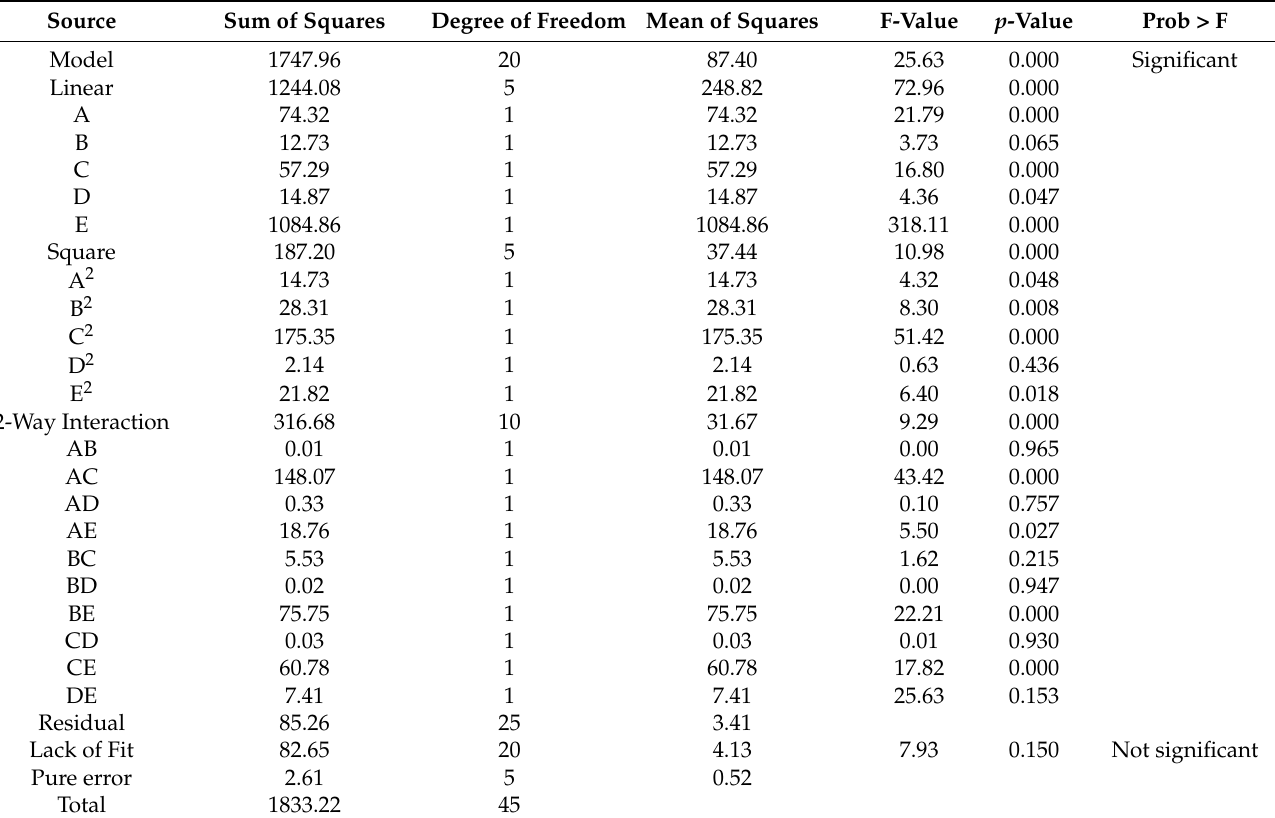
Table 4. ANOVA for the experimental results of cellulase biosynthesis by M. circinelloides